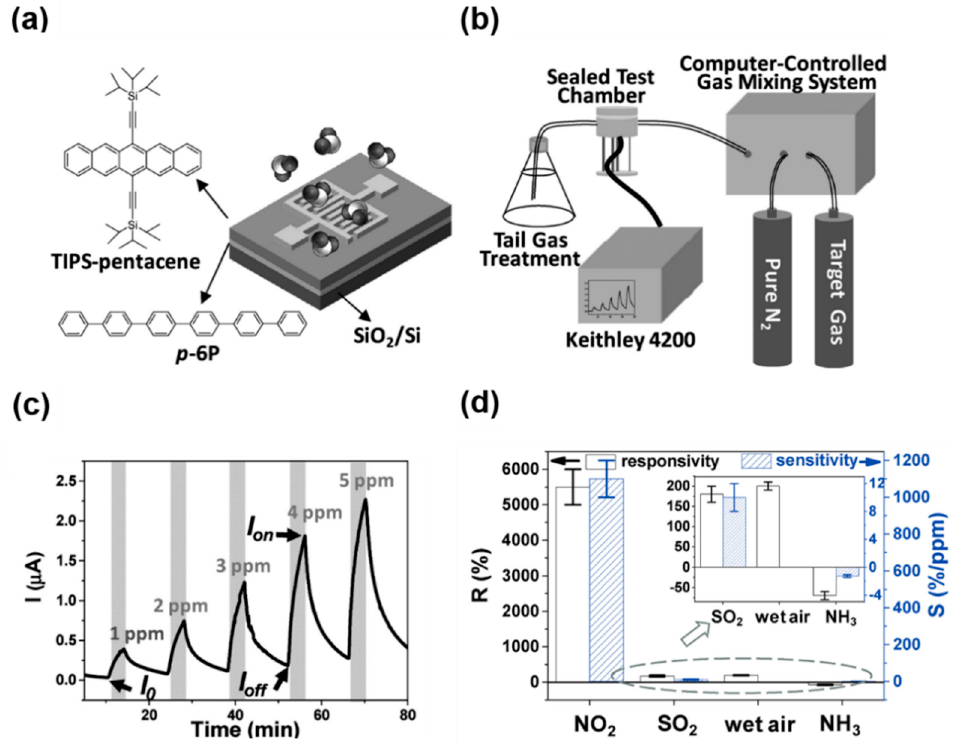
Figure 3. ( a ) Device configuration of TIPS-pentacene FET sensors, ( b ) sensor setup system, ( c ) dy- namic response of the TIPS-pentacene/para-sexiphenyl ( p -6P) film upon periodic exposure to NO 2 (1–5 ppm), and ( d ) responsivity (R) and sensitivity (S) to different gases (NO 2 , SO 2 , wet air, and NH 3 ) [74]. Copyright 2017 Wiley.